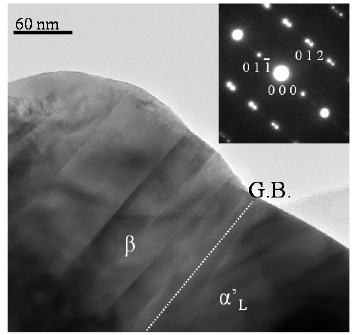
Figure 7. TEM image taken from the ( 1 00) and SAED pattern of (Ca 1.95 Eu 2+0.02 □ 0.03 )(Si 0.94 P 0.06 )O 4 phosphor annealed at 1473 K.